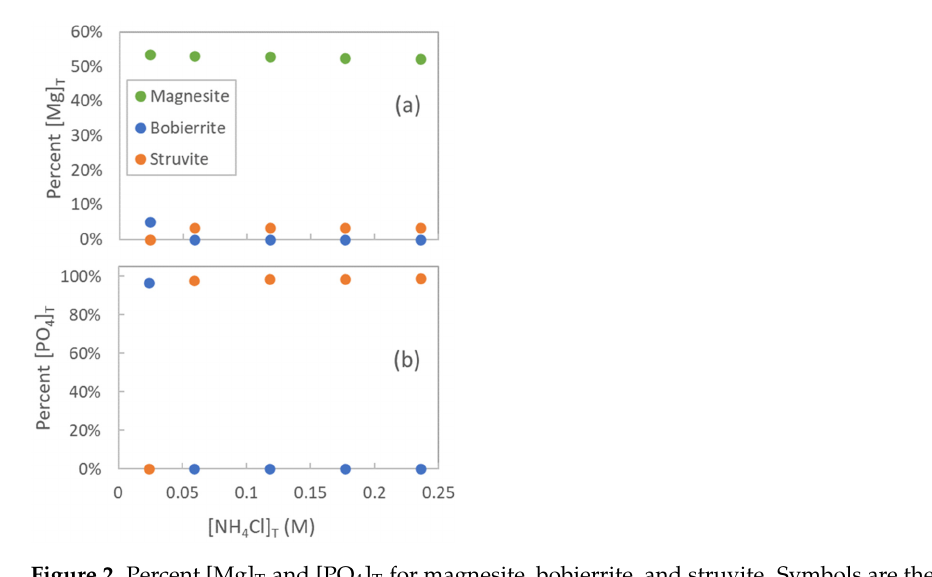
Figure 1. Measured and modeled concentrations of total dissolved ( a ) [Mg] T , ( b ) [NH 4 ] T , and ( c ) [PO 4 ] T . Filled symbols are measured values and open symbols are values calculated using MINEQL+. Error bars (for measured values only) are the standard deviations of means of duplicate measurements. In some cases, these error bars are too small to be visible.